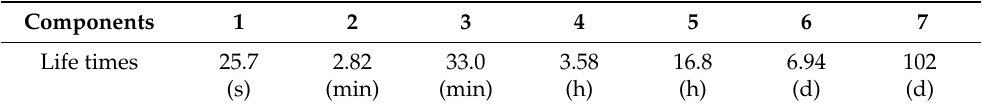
Table 21. Life times of components from activation contributions to the total TPX count rates. Taken from Ref.